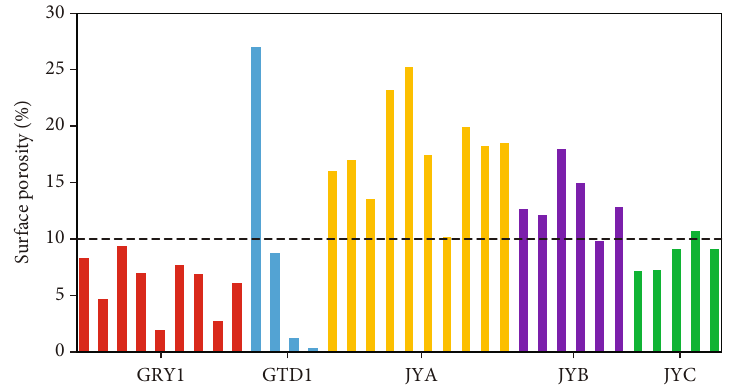
Figure 18: Surface porosity of shale samples in the study area and Jiaoshiba